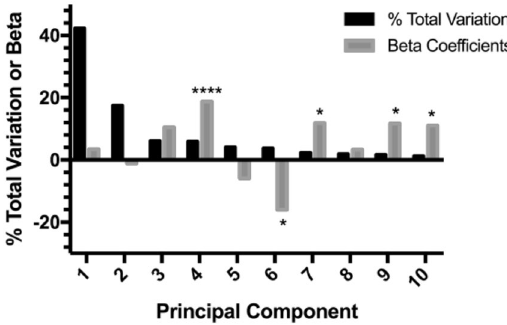
Figure 4. X-axis represent the principal component, and Y-axis represents the percent total variation of principal components or beta coefficient, respectively. Only the first 10 principal components (Pc) are displayed. Black bars represent the percentage of the sum of all possible eigenvalues; the Eigen value % of total variation. Gray bars represent the beta coefficients from regressions; model: (BMI i = Age i + Smoking i + Pc k ) where i = ( 1 , … , 126 ) and k = ( 1 , … , 10 ). * p-value < 0.05 and **** p-value < 0.0001. Body mass index